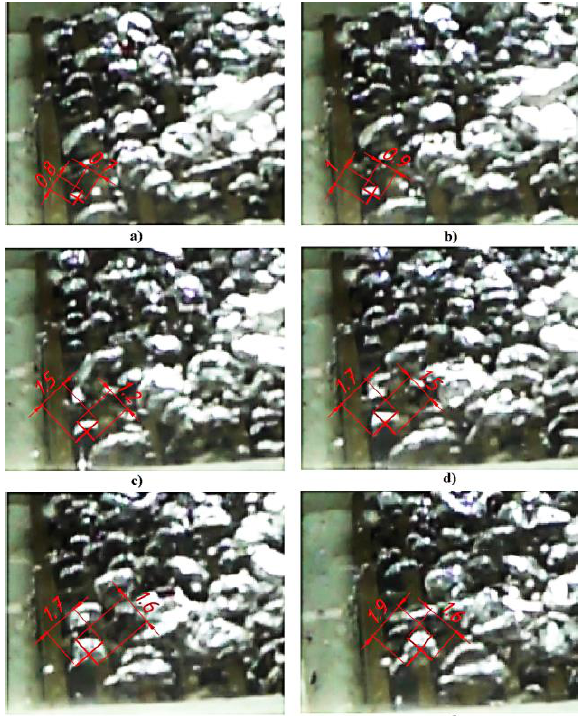
Fig. 5. Visualization of the pool boiling of Novec-649 on the surface of the minichannels surface MCC-M-4.2-0.5-2, q = 27.9 kW/m 2 , a) t = 1 ms, b) t = 4 ms , c) t = 8 ms, d) t = 12 ms, e) t = 16 ms, f) t = 20